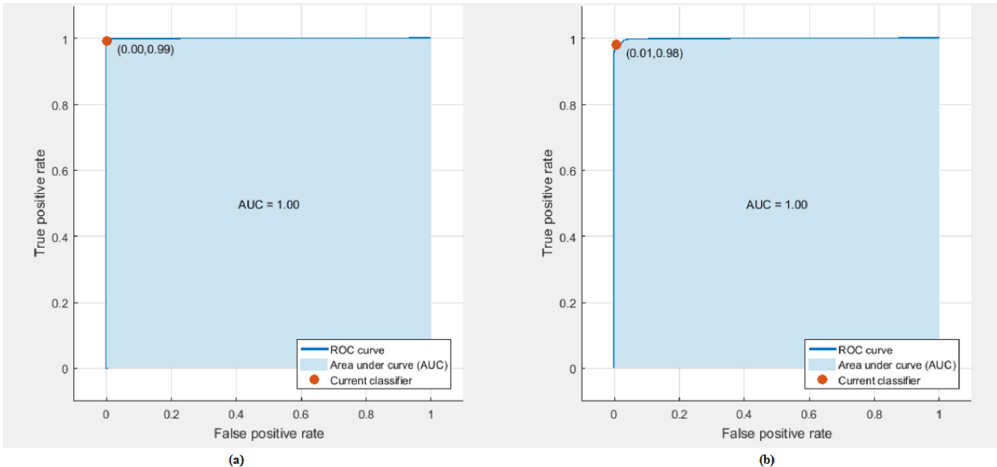
Figure 6. The classification accuracies for classifying stress levels using our three subsets of features. Table 4. Evaluation metrics (with their 95% confidence intervals) for evaluating stress levels using Feature-Set 3 .